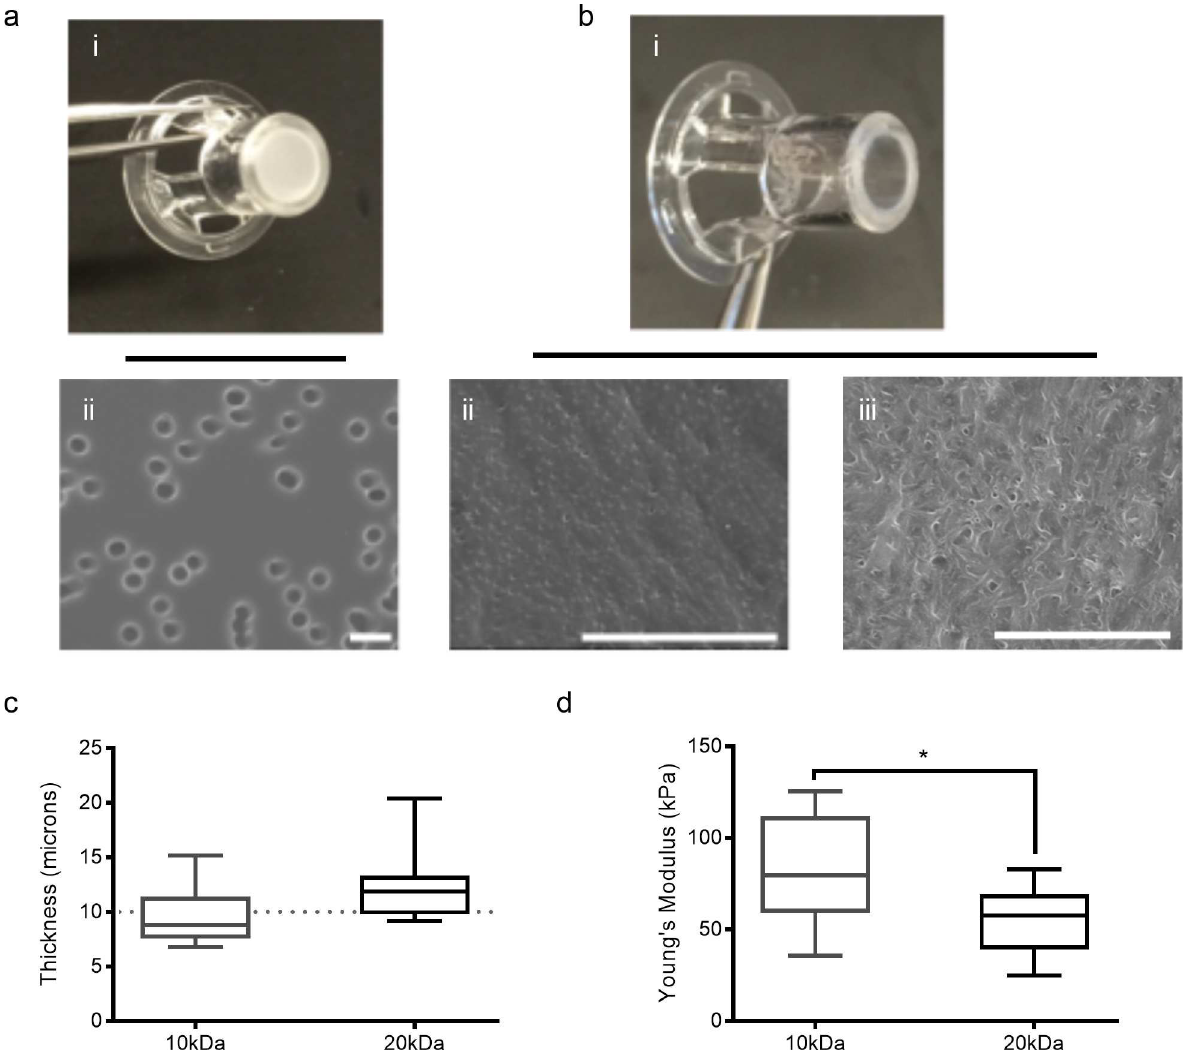
Fig 1. Zinc oxide micro-needles introduce pores into PEG hydrogels. (a-b) Images of commercialTWs (a-i) and porated PEG hydrogels in TW casing (b-i). SEM micrographs of TWs (a-ii), 10kDa (b-ii), and 20kDa (b-iii) porated PEG hydrogels; scale bars: 5 microns. (c) Hydrogelthickness as determined by OCT. Whiskers denoteminimum and maximum value; there is no statistical difference between10kDa and 20kDa hydrogels. (d) Young’smodulusof 10kDa and 20kDaporated PEG hydrogels. Whiskers denoteminimum and maximum value; * p <